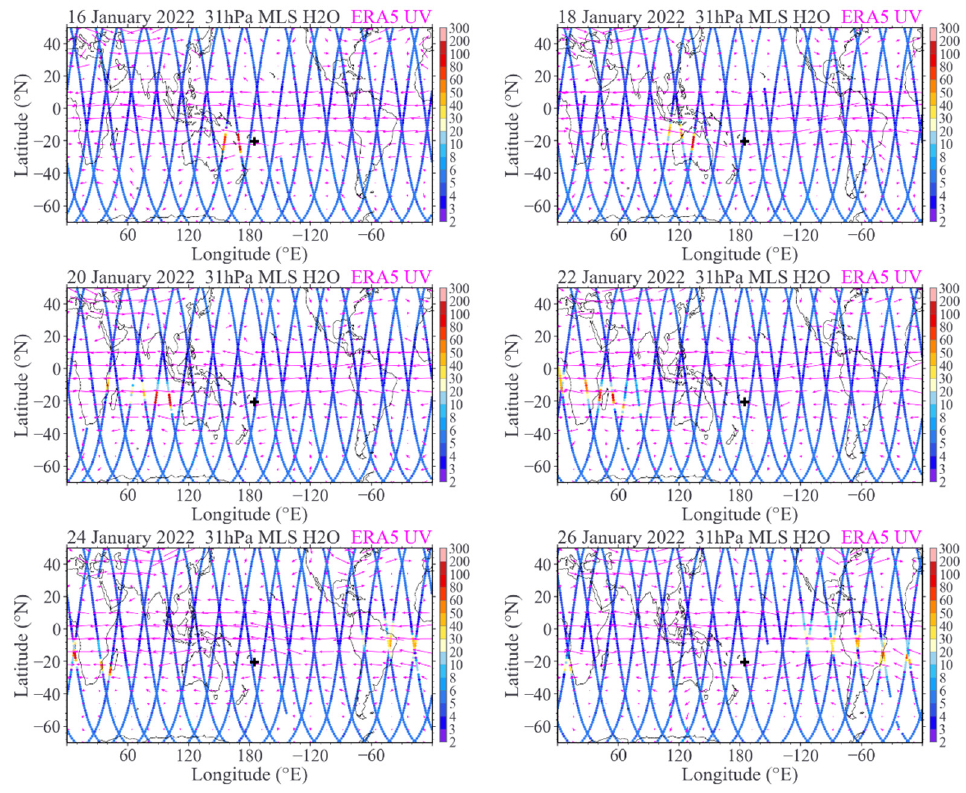
Figure 1. Water vapor (dots) mixing ratio (VMR, ppmv) at 31 hPa derived from MLS/Aura and wind field (magenta vectors) from the ERA5 reanalysis at 30 hPa at 00:00 UTC during 16–26 January 2022. The plus sign marks the location of Tonga near 20 ◦ S, 175 ◦